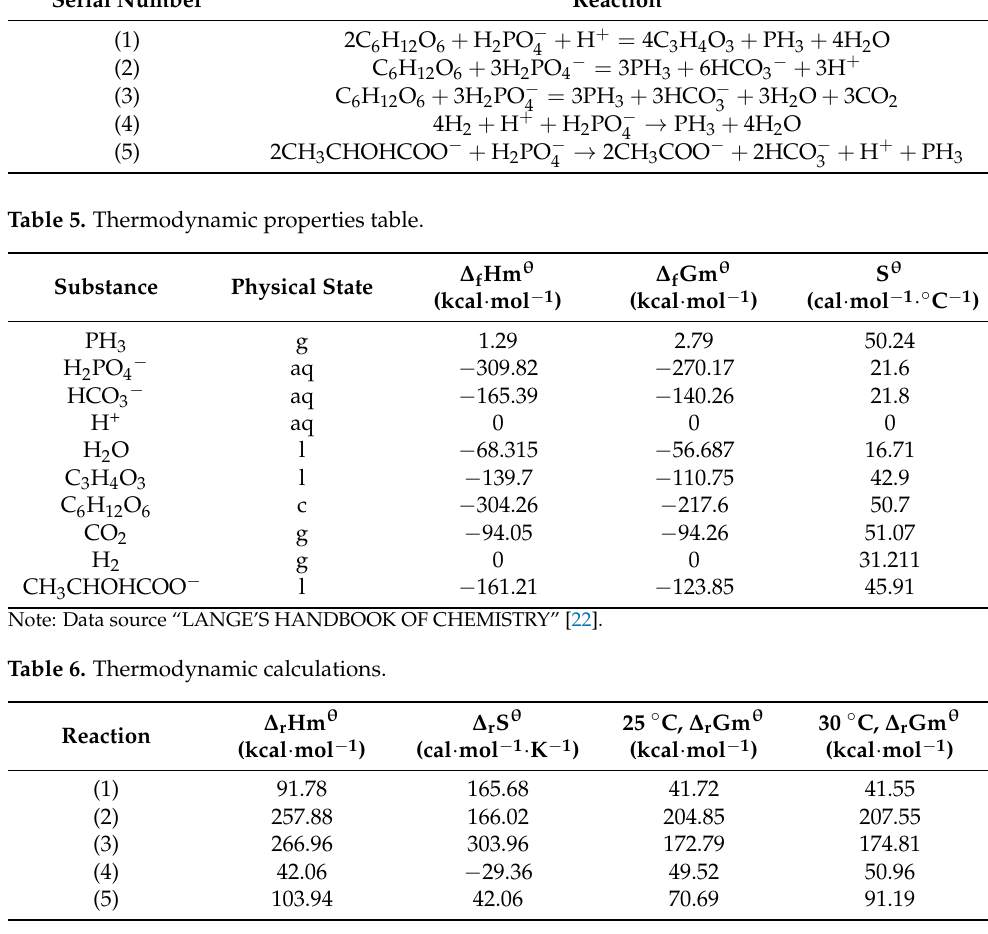
Table 4. The abundance of the metabolic pathway. Serial Number